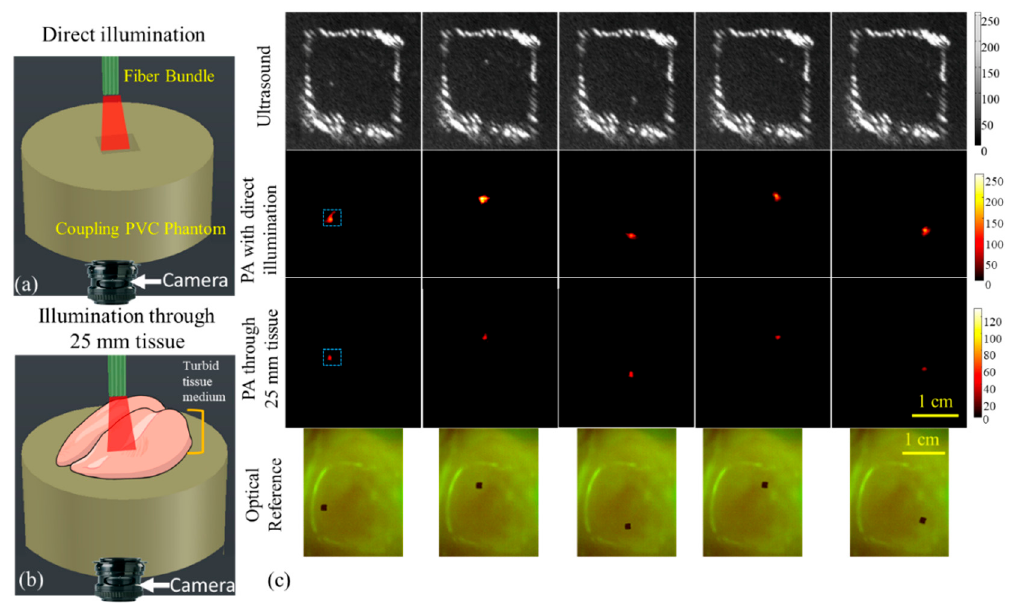
Figure 5. Imaging setup for detecting microrobots with ( a ) direct illumination and ( b ) illumination after a 25 mm chicken breast tissue, and ( c ) US images (top row), PA images with direct illumination (second row), PA imaging through opaque tissue (third row), and optical images (fourth row).